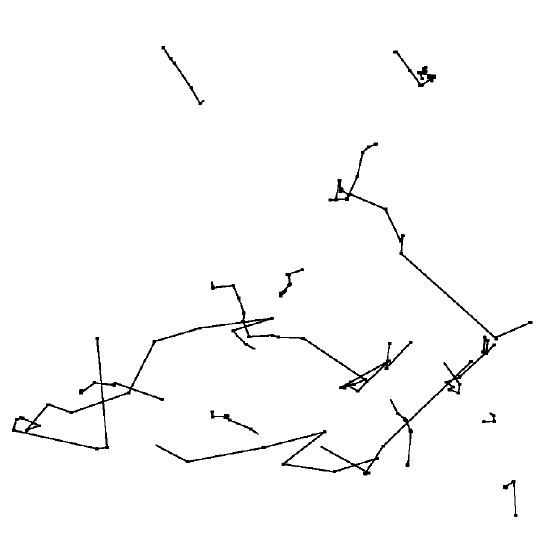
FIGURE 2. Telemetrically recorded movement pattern of the ground beetle Carabus clathratus . Each polygon represents subsequent daily positions of an individual. (Fred Jopp, unpublished data).